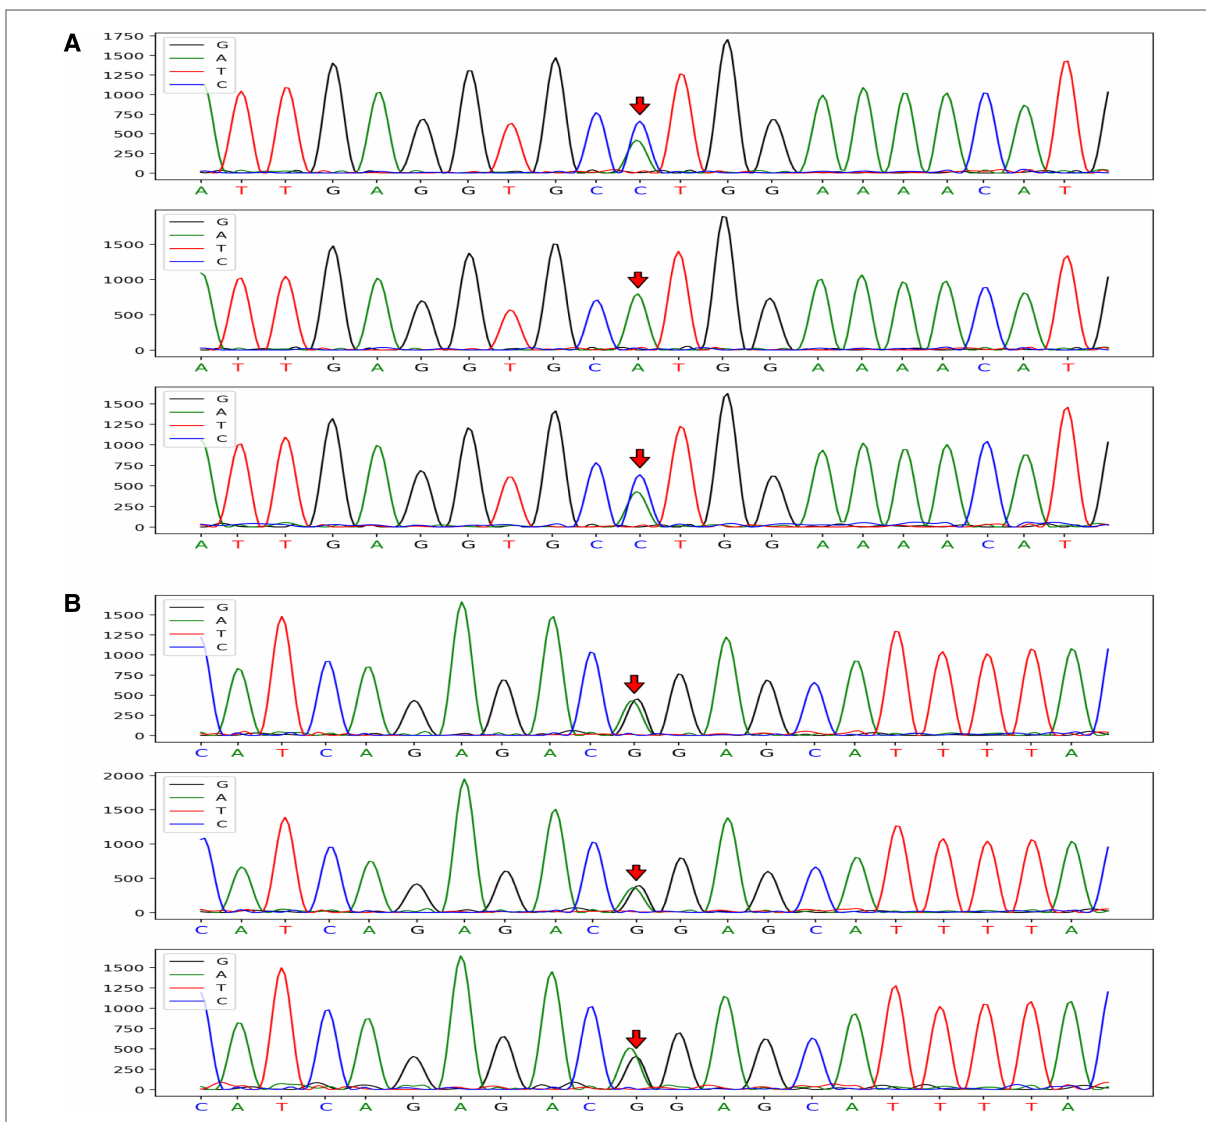
FIGURE 3 CRYAB gene sequences of the proband and her parents (mutation sites are marked with arrows). The CRYAB c.302A>C (p.H101P) mutation was located in the region of exon 3 of chromosome 11 and resulted in the mutation of the NO. 302 nucleotide from adenine to cytosine ( A ). The proband with FIHMM and her mother carried the same gene mutation; however, her father ’ s gene locus was normal. The CRYAB 3G>A (p.M1I) mutation was located in the region of exon 2 of chromosome 11 and caused the mutation of a synthetic amino acid from methionine to isoleucine ( B ). The mutation carried by the proband was inherited from her unaffected father, whereas her mother ’ s gene locus was